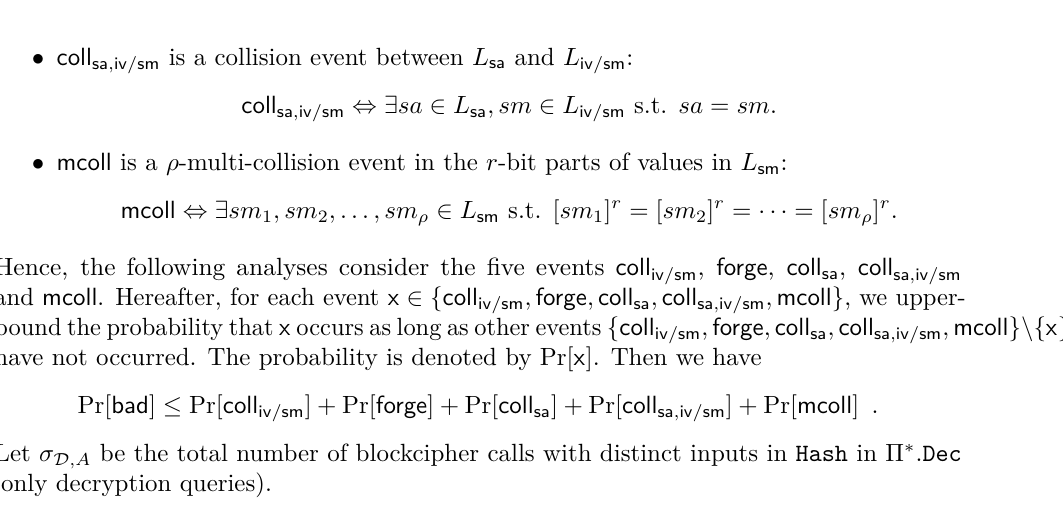
Figure 3: Subroutines in World 1 (without boxed statements) and World 2 (with boxed